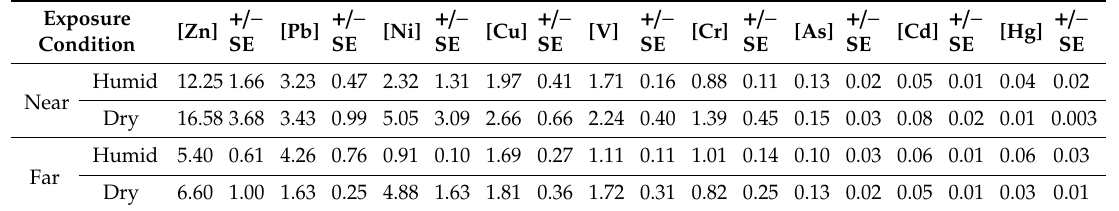
Table 2. Element content (mg kg − 1 ) in moss bags. Data reported as mean values +/ − standard error. Exposure